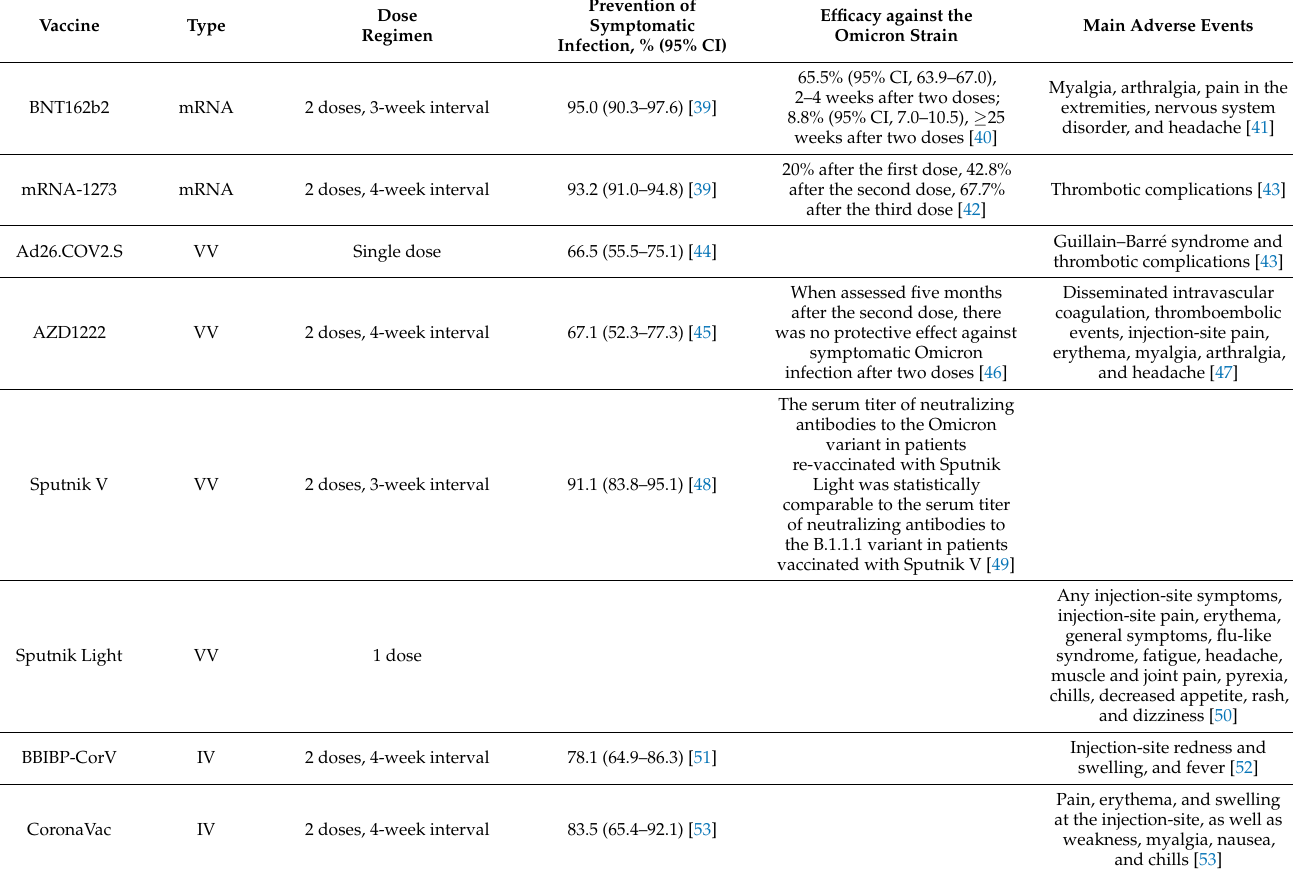
Table 2. Characteristics of the main anti-SARS-CoV-2